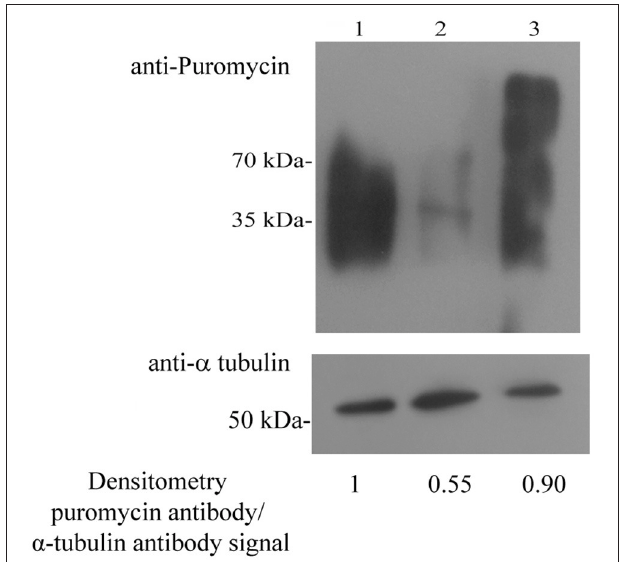
FIGURE 2 | Protein synthesis, measured using puromycin-labeled proteins in control E. histolytica trophozoites, TEANS, and NAT Lane 1. Control E. histolytica trophozoites. Lane 2. TEANS. Lane 3. NAT. Whole protein extracts were separated by denaturing electrophoresis and analyzed by western blotting (upper panel) using a puromycin antibody or a α -tubulin antibody (lower panel) . Densitometric quantification of the puromycin antibody/ α -tubulin antibody signal. The signal from control trophozoites was set at 1 and the results are representative of two independent